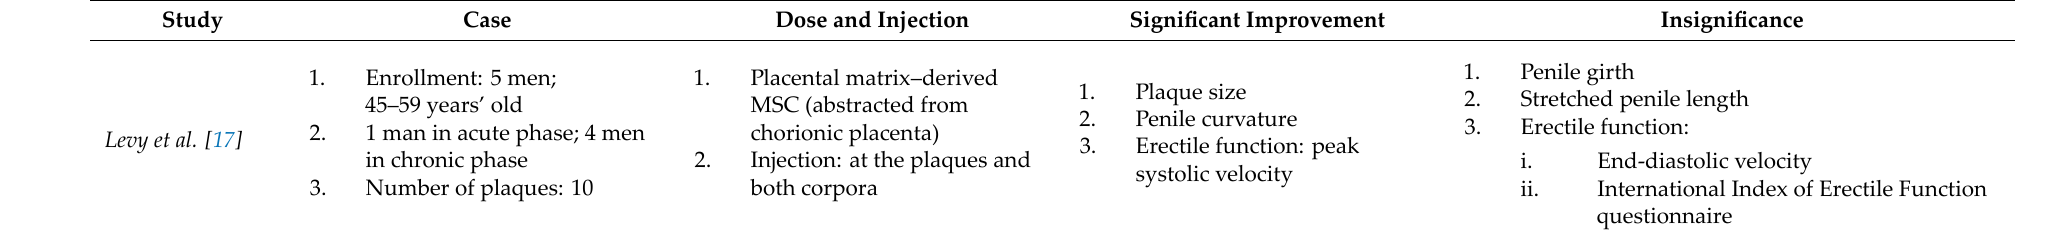
Table 3. Conclusion of the current human clinical studies of SC in